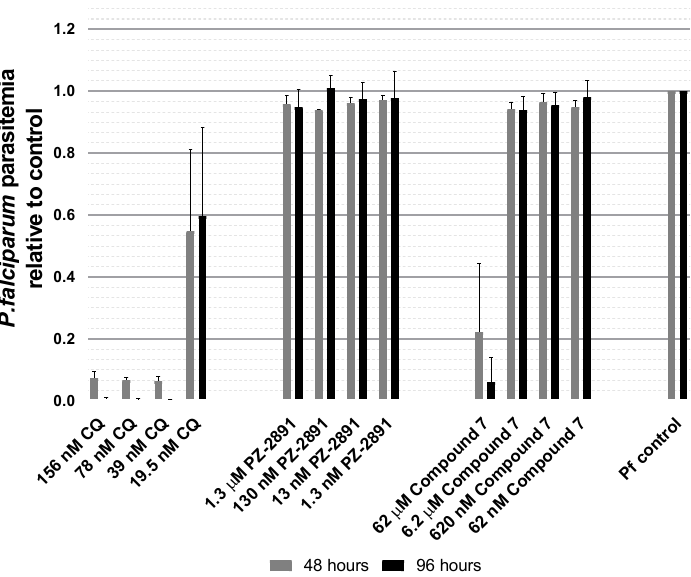
Figure 5. PZ-2891 and compound 7 at doses used in our biological assays had no direct effects on P. falciparum NF54 growth in vitro. Synchronized asexual stage P. falciparum NF54 strain was grown and treated with medium supplemented with chloroquine as a positive control for parasite killing (156 nM, 78 nM, 39 nM or 19.5 nM), PZ-2891 (1.3 µM, 130 nM, 13 nM or 1.3 nM), compound 7 (62 µM, 6.2 µM, 620 nM or 62 nM) or DMSO as a negative control at a volume equivalent to that used to deliver small molecules (indicated as “Pf control”, set to 1). Samples were collected 48 h and 96 h after treatment, stained with PI and analyzed by flow cytometry. The data are represented as mean parasitemia +/ − SEM of the treated cultures relative to Pf control. The assays were replicated twice with distinct parasite cultures.